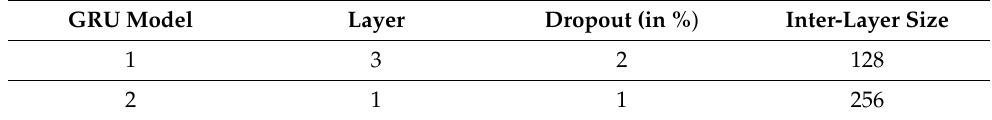
Table 2. GRUs used in the proposed